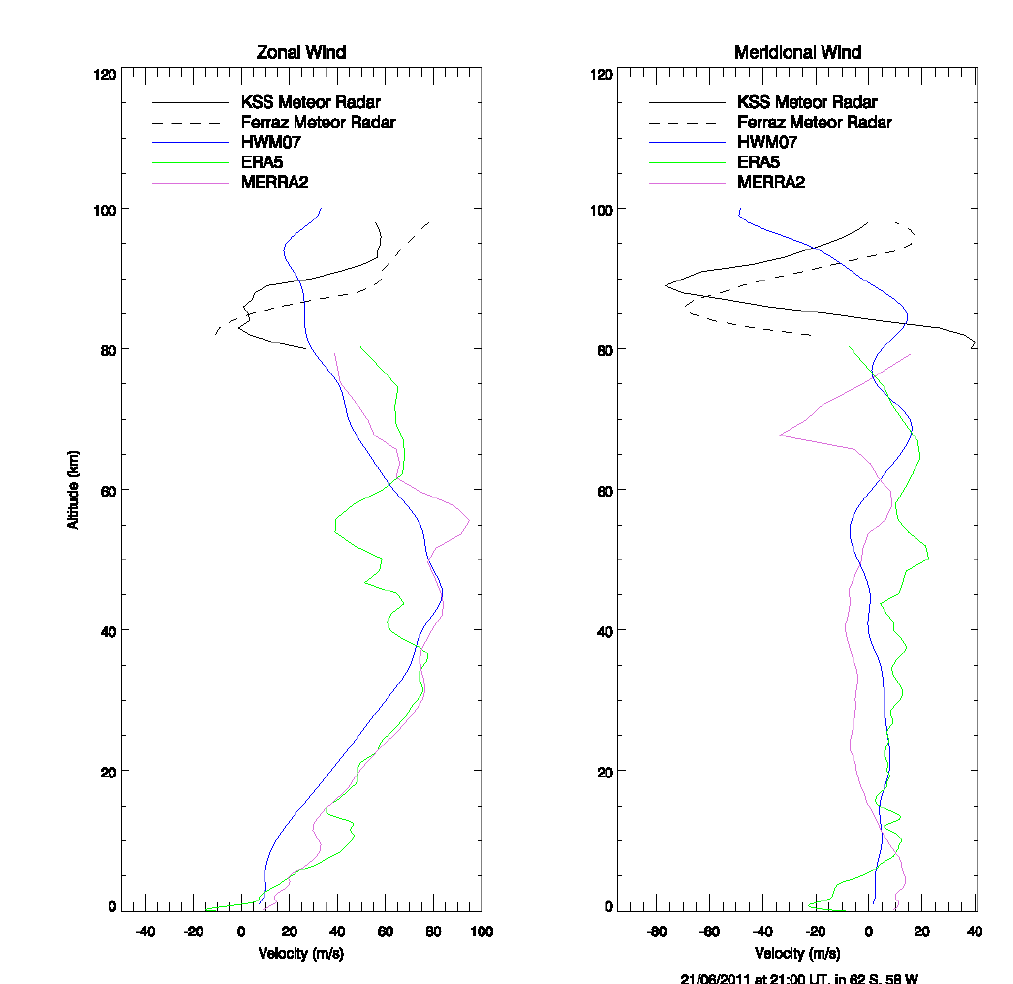
Figure 2. Winds over Comandante Ferraz Antarctic Station (EACF or Ferraz Station) measured by King Sejong Station (KSS) (black line) and Ferraz (black dashed) meteor radars. HWM-07 model (blue lines), ERA-5 (green line) and MERRA-2 reanalysis (purple line), for 21 June 2011 at 21:00